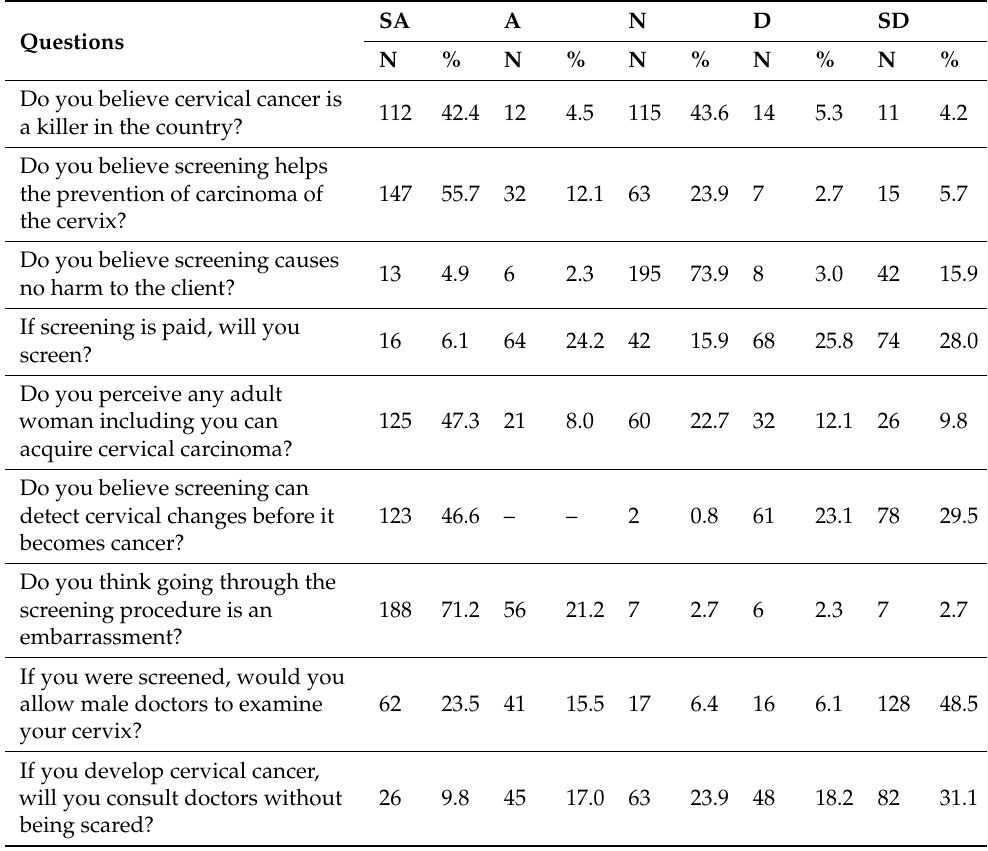
Table 2. Perceptions of female nurses towards cervical cancer